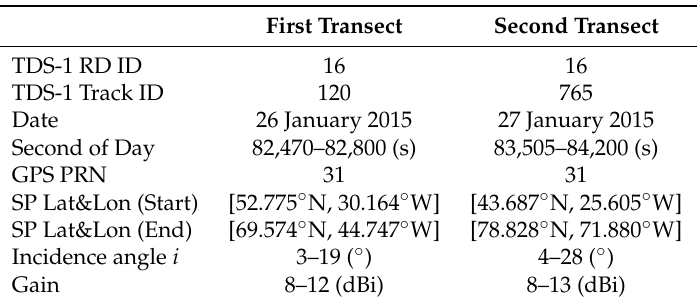
Table 1. Selected TDS-1 Data